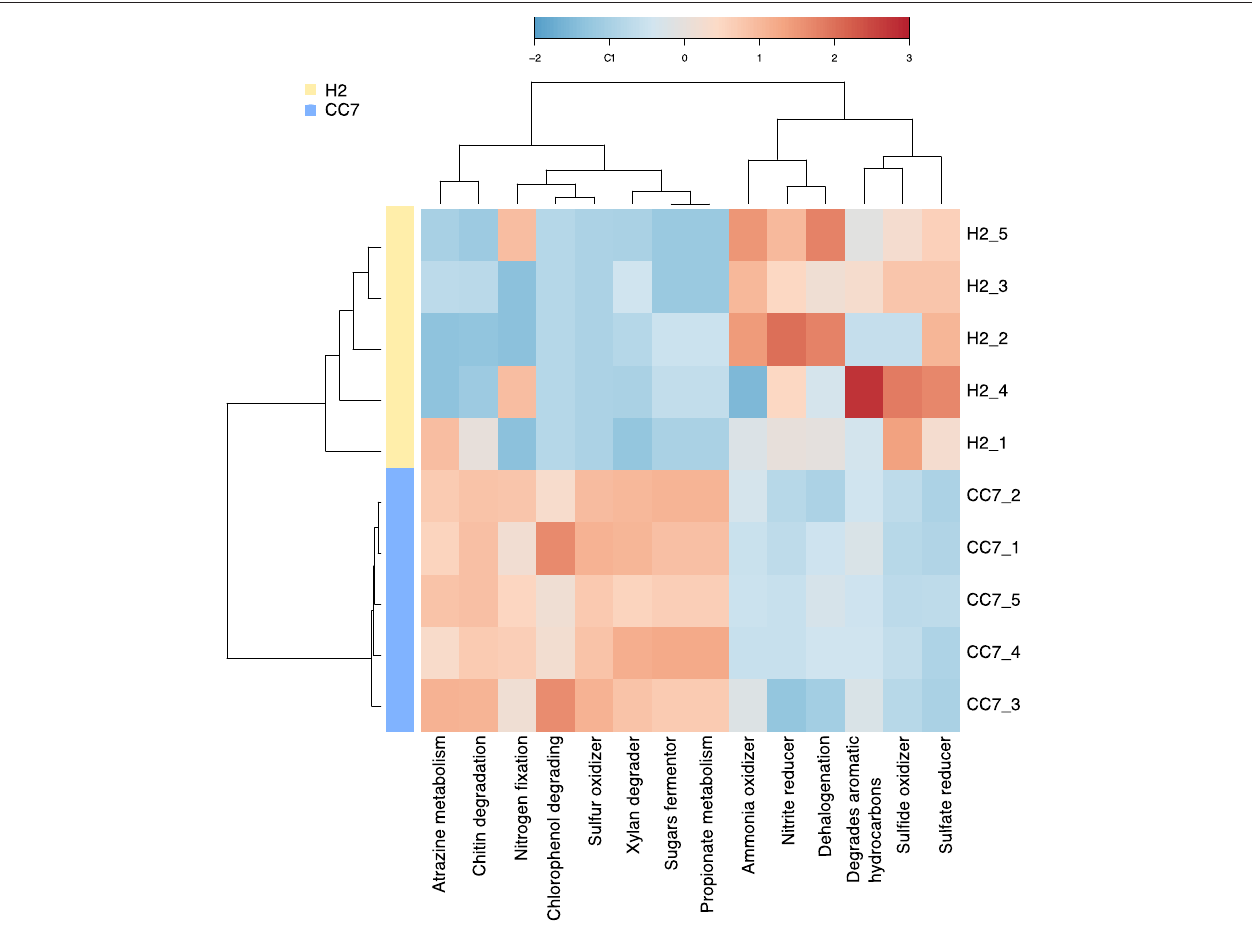
FIGURE 2 | Taxonomy-based functional profiling of Exaiptasia H2 and CC7 bacterial communities. Changes in putative functional differences between both populations are displayed on a relative scale with enrichment in red and depletion in blue. H2 is a female clonal strain originally isolated from Hawaii, USA. CC7 is a male clonal strain originally from North Carolina,